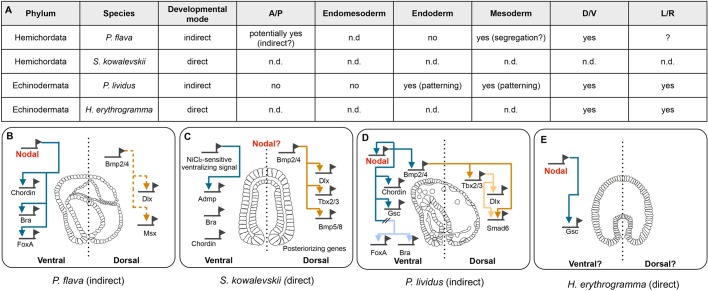
Comparison of the role and molecular mechnaisms of Nodal signaling in ambulacrarians. (A) Identified roles of Nodal signaling in ambulacrarians. (B-E) diagrams representing the molecular mechanism underlying D/V patterning in ambulacrarians. Hemichordates: P. flava (indirect development) and S. kowalevskii (direct development) (this study; Lowe et al., 2006). Echinoderms: P. lividus (indirect development) and H. erythrogramma (direct development) (Duboc et al., 2004; Lapraz et al., 2009b; Saudemont et al., 2010; Smith et al., 2008; Su et al., 2009).